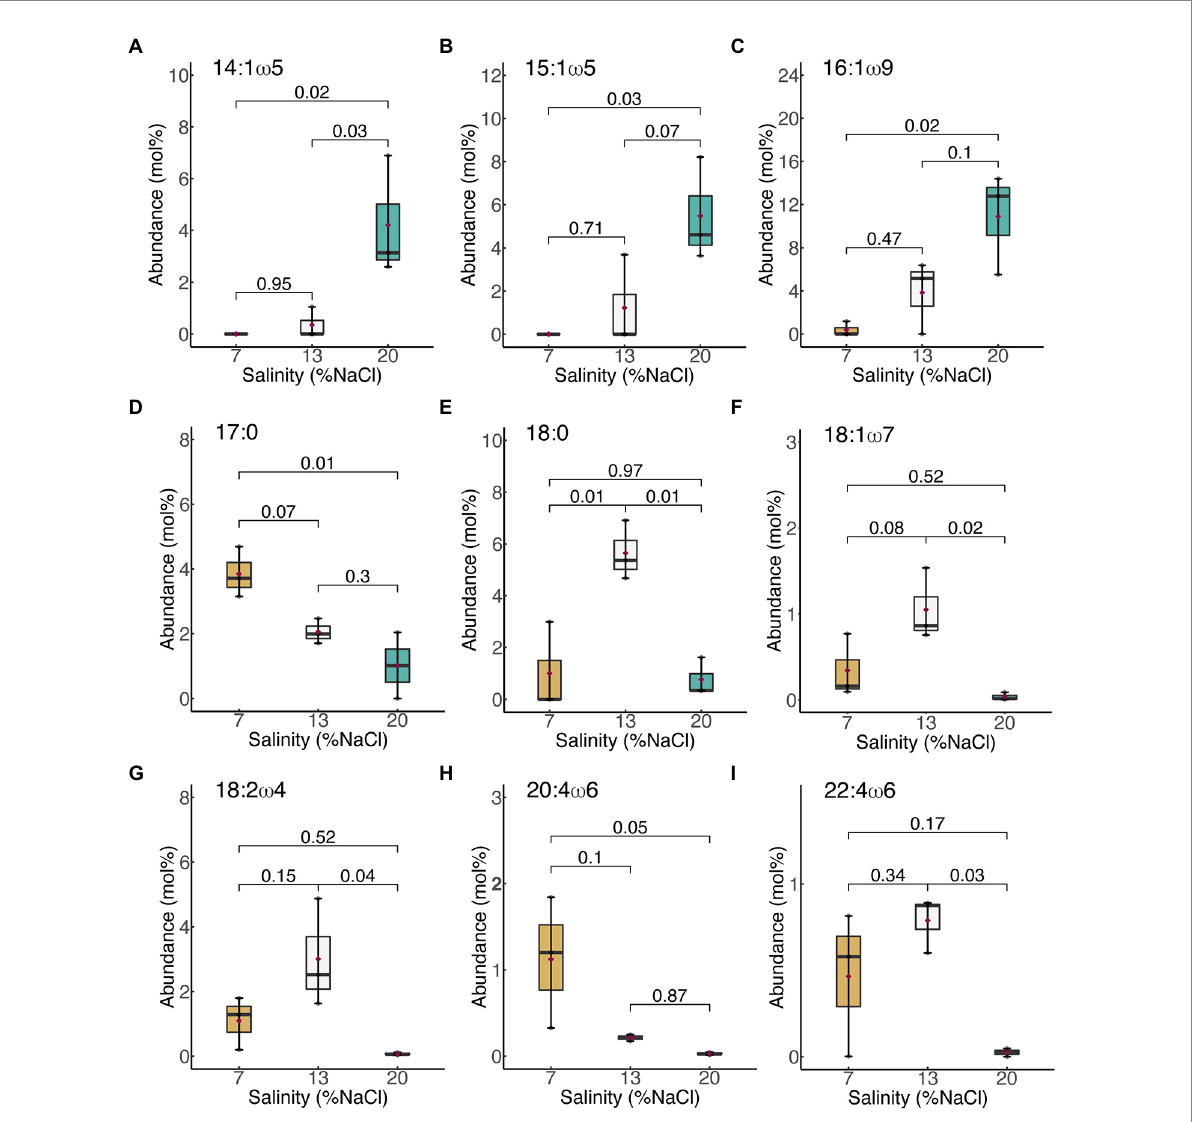
FIGURE 2 Membrane-derived fatty acids that significantly varied with salinity in H. congolense WG10. (A) 14:1 ω 5; (B) 15:1 ω 5c; (C) 16:1 ω 9c; (D) 17:0; (E) 18:0; (F)